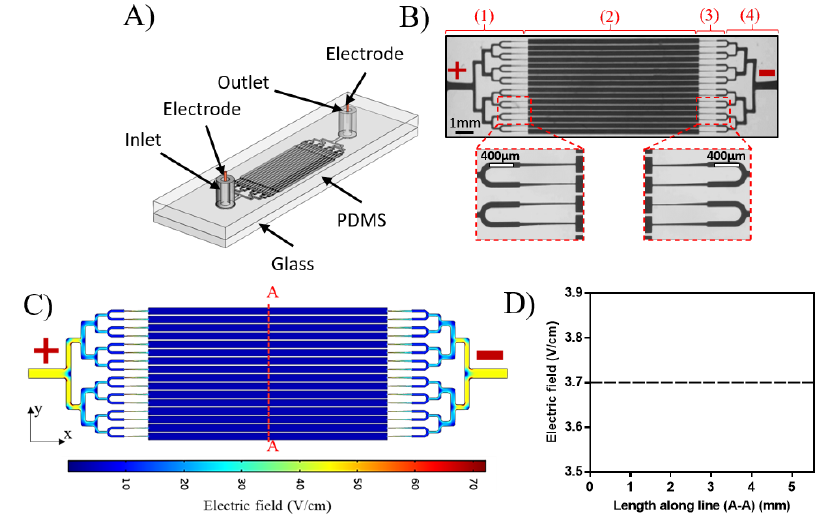
Figure 2. ( A ) Schematic of the parallel electrotaxis microfluidic chip (3 cm × 1.5 cm) consisting of one inlet and one outlet that are connected by four modules shown in ( B ): (1) worm loading and distribution channels, (2) 16 parallel electrotaxis screening channels, (3) tapered channels for worm immobilization and imaging, and (4) unloading channels. ( C ) Electric field distribution throughout the chip simulated using COMSOL by applying 50 V to achieve a constant electric field of 3.7 V/cm in electrotaxis screening channels ( D